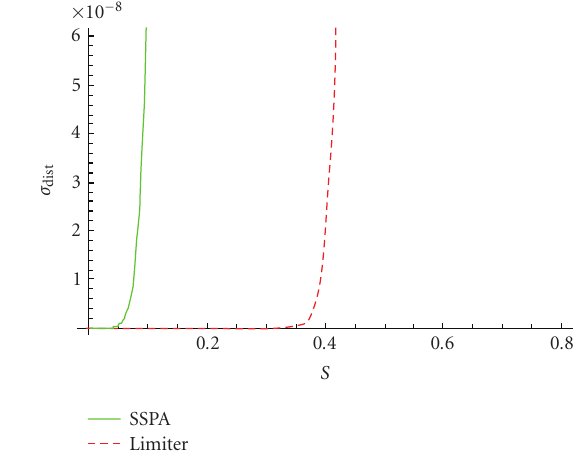
Figure 5: Nonlinear amplifier distortion versus s , with saturation level a = 2 ( A IP3 = 10dB).